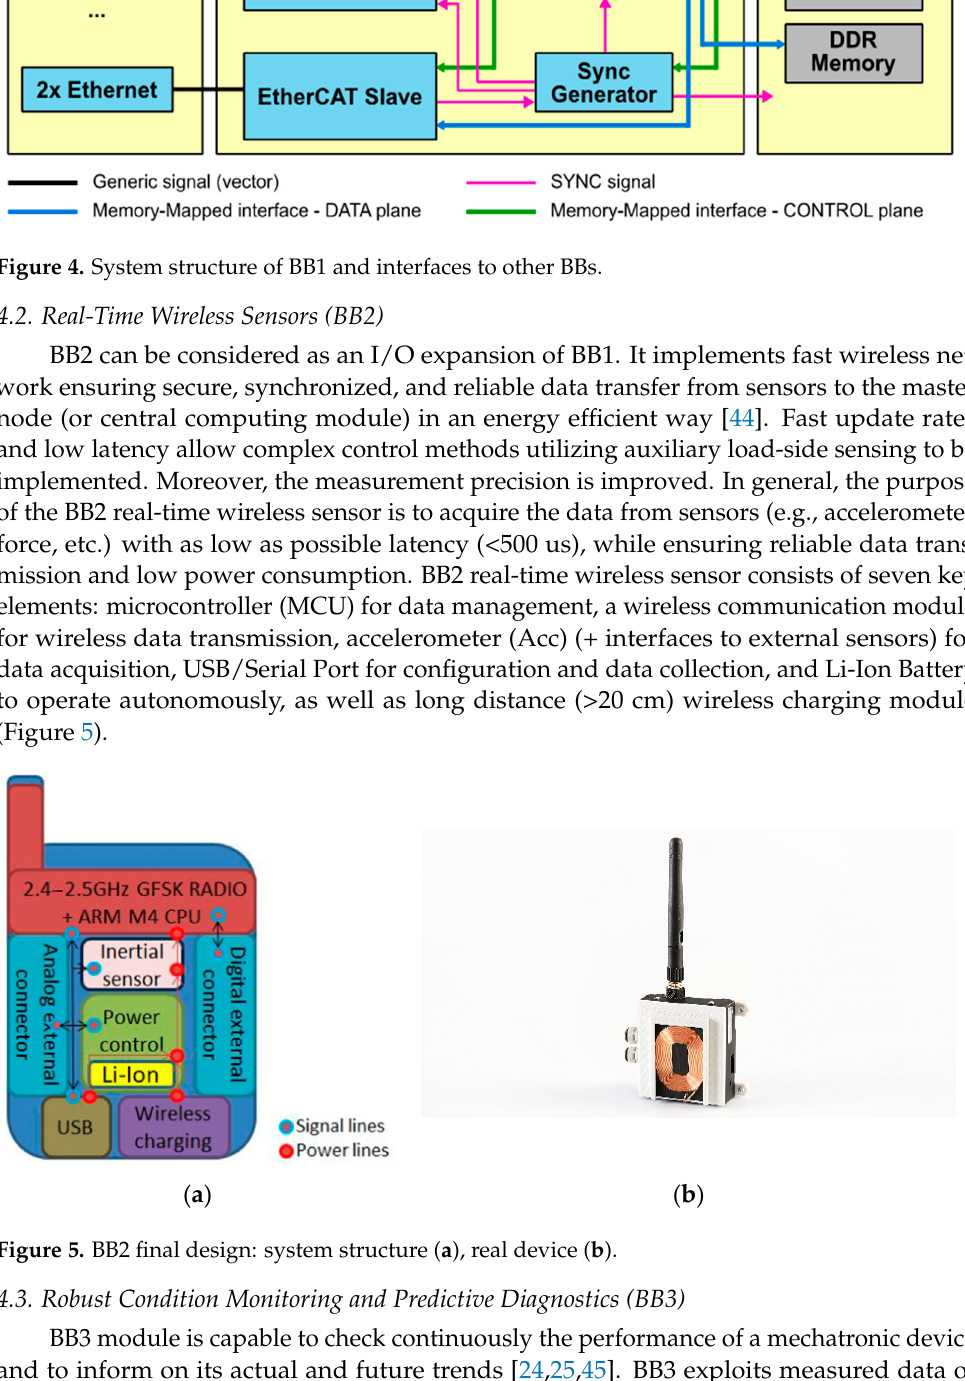
Figure 5. BB2 final design: system structure ( a ), real device ( b ).